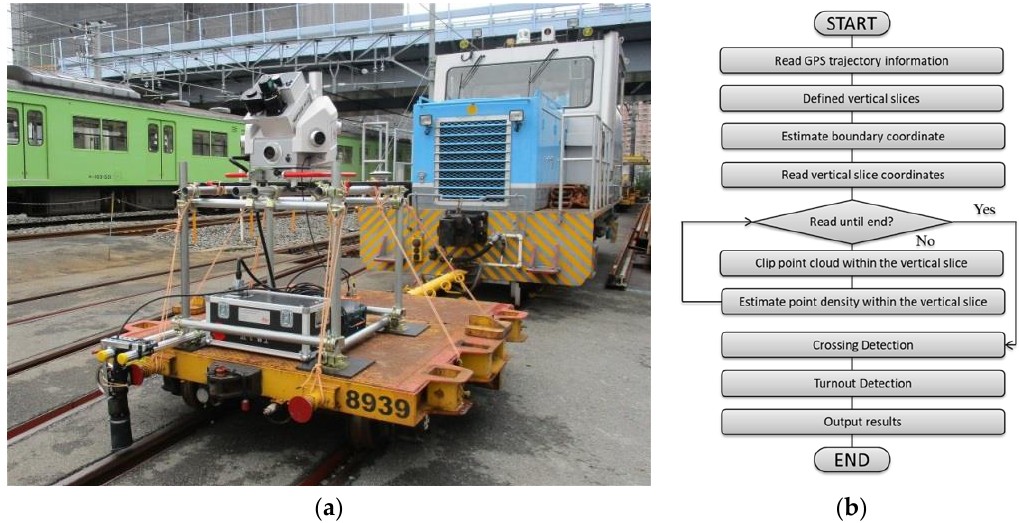
Figure 10. ( a ) MLS survey setup with the LiDAR sensor and ( b ) processing flow chart.